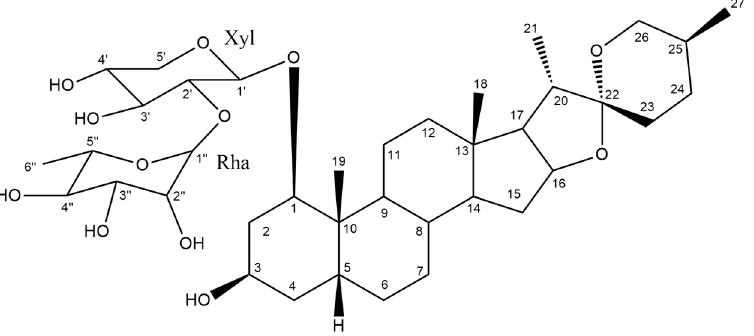
Figure 1. The structure of RCE ‐ 4 (1 β , 3 β , 5 β , 25S) ‐ spirostan ‐ 1,3 ‐ diol1 ‐ [ α‐ L ‐ rhamnopyranosyl ‐ (1 → 2) ‐β‐ D ‐ xylopyranoside].